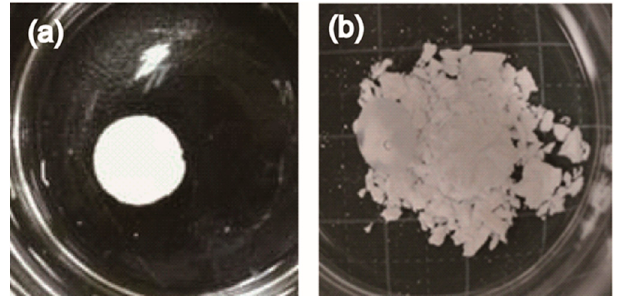
Figure 4. SEM micrographs of Ag-TCP(5) cement. SEM images of the surface of Ag-TCP(5) cement. ( b ) represents high magnification of indicated area. Bars indicate 5 μ m ( a ) and 1 μ m ( b ), respectively.